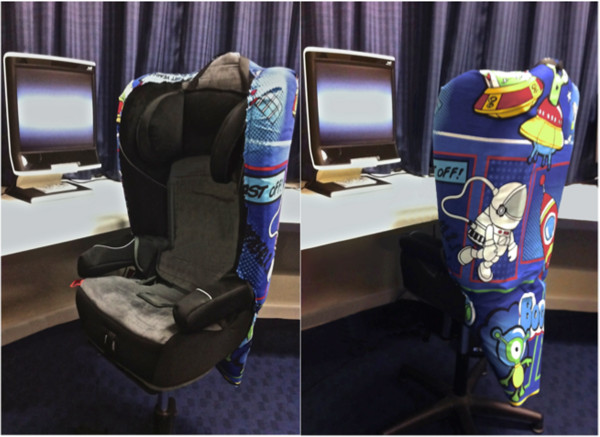
Experimental set-up.